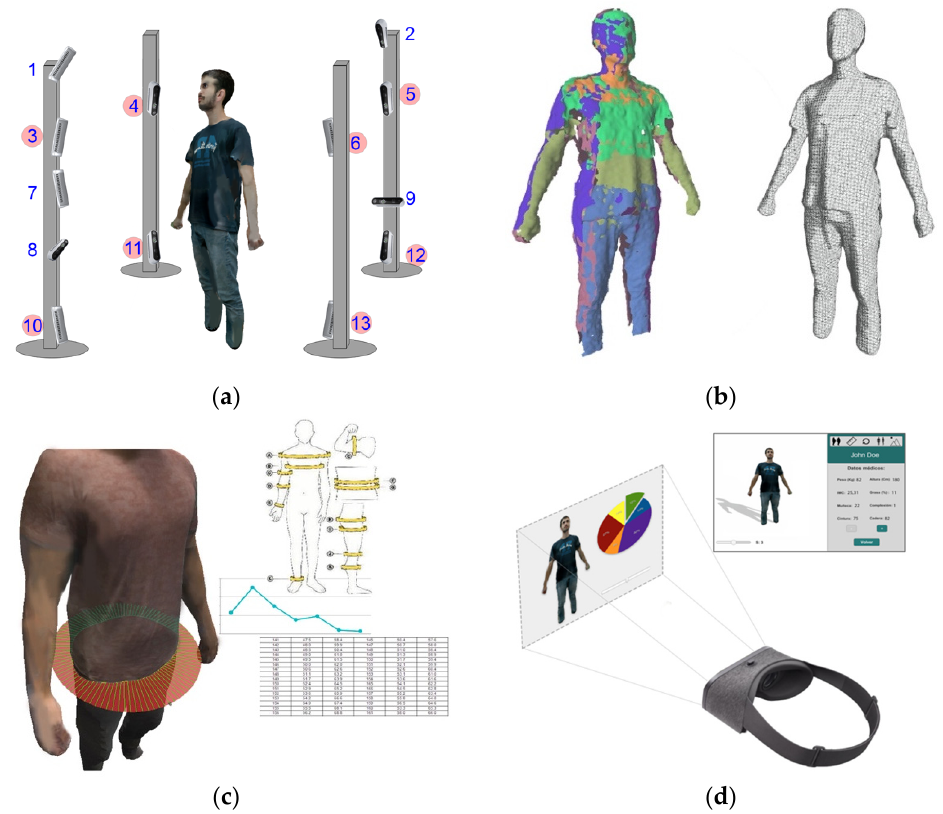
Figure 1. Proposed framework system based on an RGB-D camera network ( a ). Body models: point clouds and mesh ( b ). 3D body measurement ( c ) and textured representation with virtual reality (VR) devices ( d ).